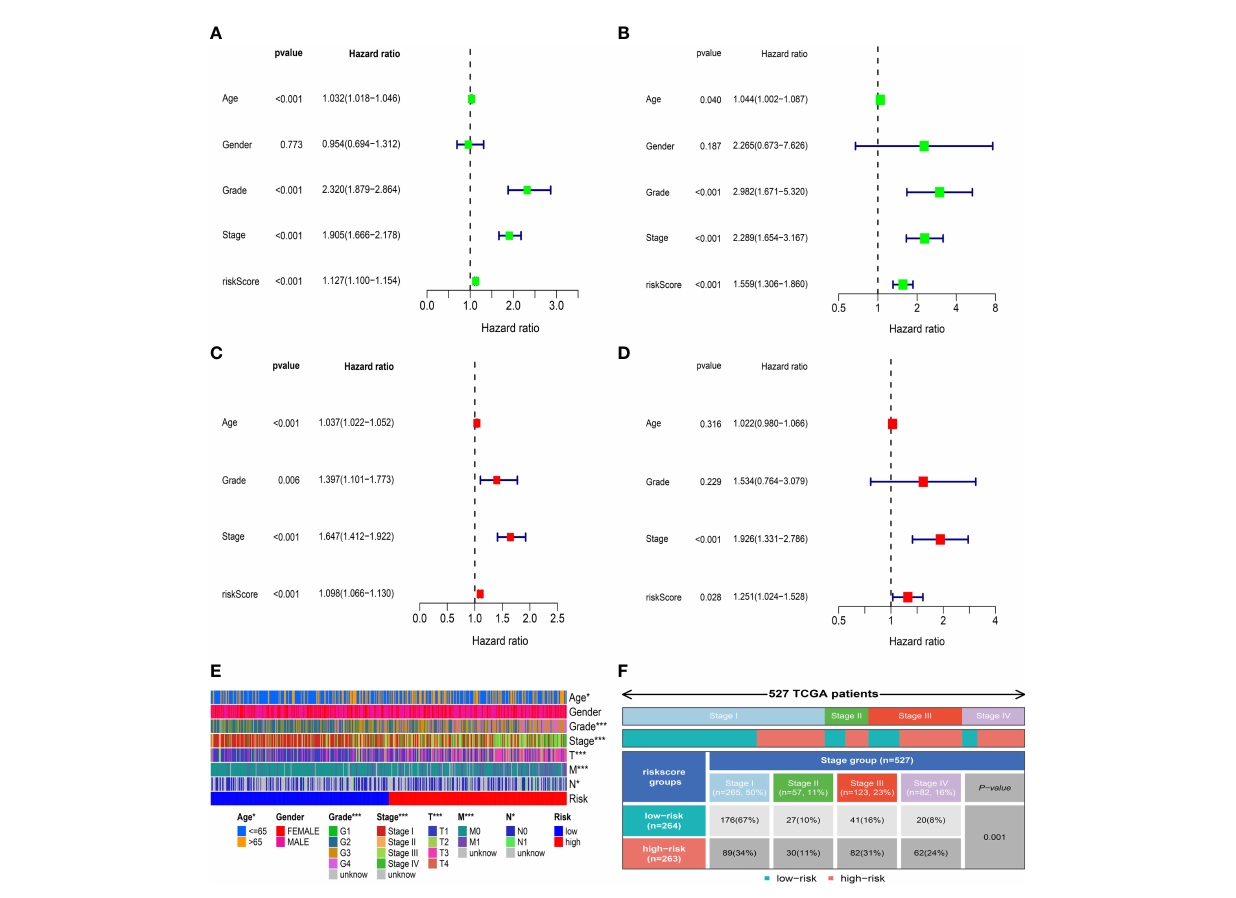
FIGURE 6 Correlation between risk score and clinical characteristics. (A, C) Univariate and multivariate Cox regression analyses showed that risk score was an independent prognostic indicator in the TCGA-KIRC dataset. (B, D) Univariate and multivariate Cox regression analyses showed that risk score was an independent prognostic indicator in the E-MTAB-1980 dataset. (E) Differences in clinical characteristics between the low- and high-risk groups in the TCGA-KIRC dataset. (F) Distribution of tumor stages between the low- and high-risk groups. * p<0.05, ***